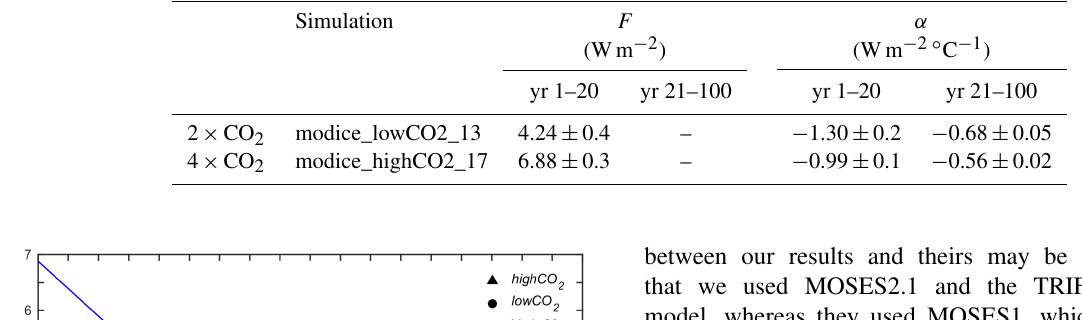
Table 3. Parameter values estimated from Gregory plots for the 2 × and 4 × pre-industrial CO 2 simulations. Shown are the effective radiative forcing ( F , Wm − 2 ) and the climate feedback parameter ( α , Wm − 2 ◦ C − 1 ) for years 1–20 and 21–100. The uncertainties are the standard error from the linear regression.